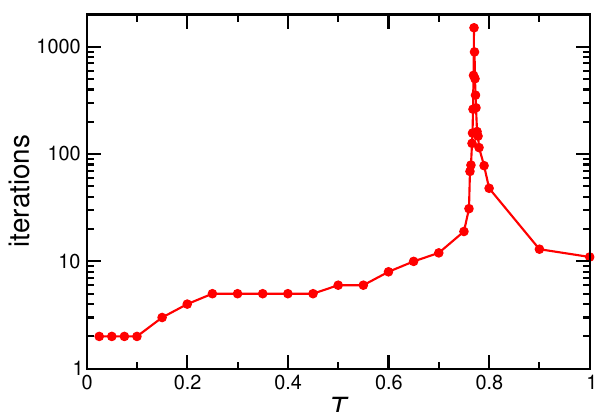
Figure A2. Number of iterations performed for the N = 100 QMC data in Figure 8 (recall that J = 1). Actual data are indicated by filled circles; lines are guides to the